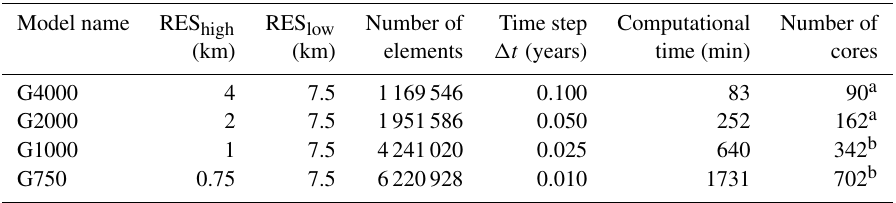
Table 1. Summary of models and their mesh characteristics. Computational time is based on a projection run under MIROC5 RCP 8.5 and medium ocean